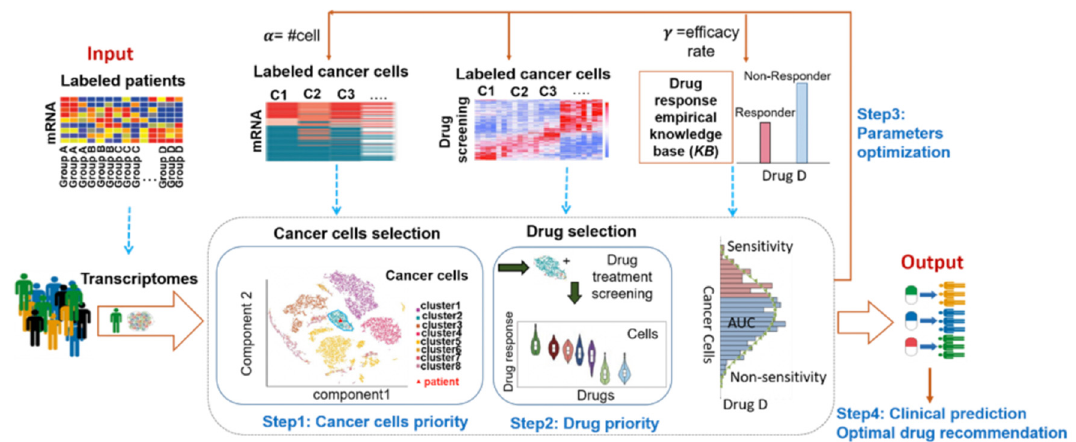
precision cancer Figure 1. Computational cancer cell model, called the optimal two-layer decision system, to guide precision cancer medicine.